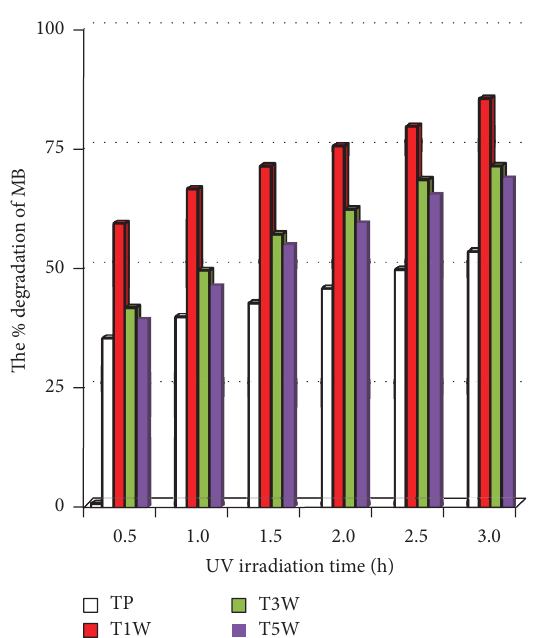
Figure 5: The degradation percentage of WO 3 -doped TiO 2 coated CA on degradation of MB.